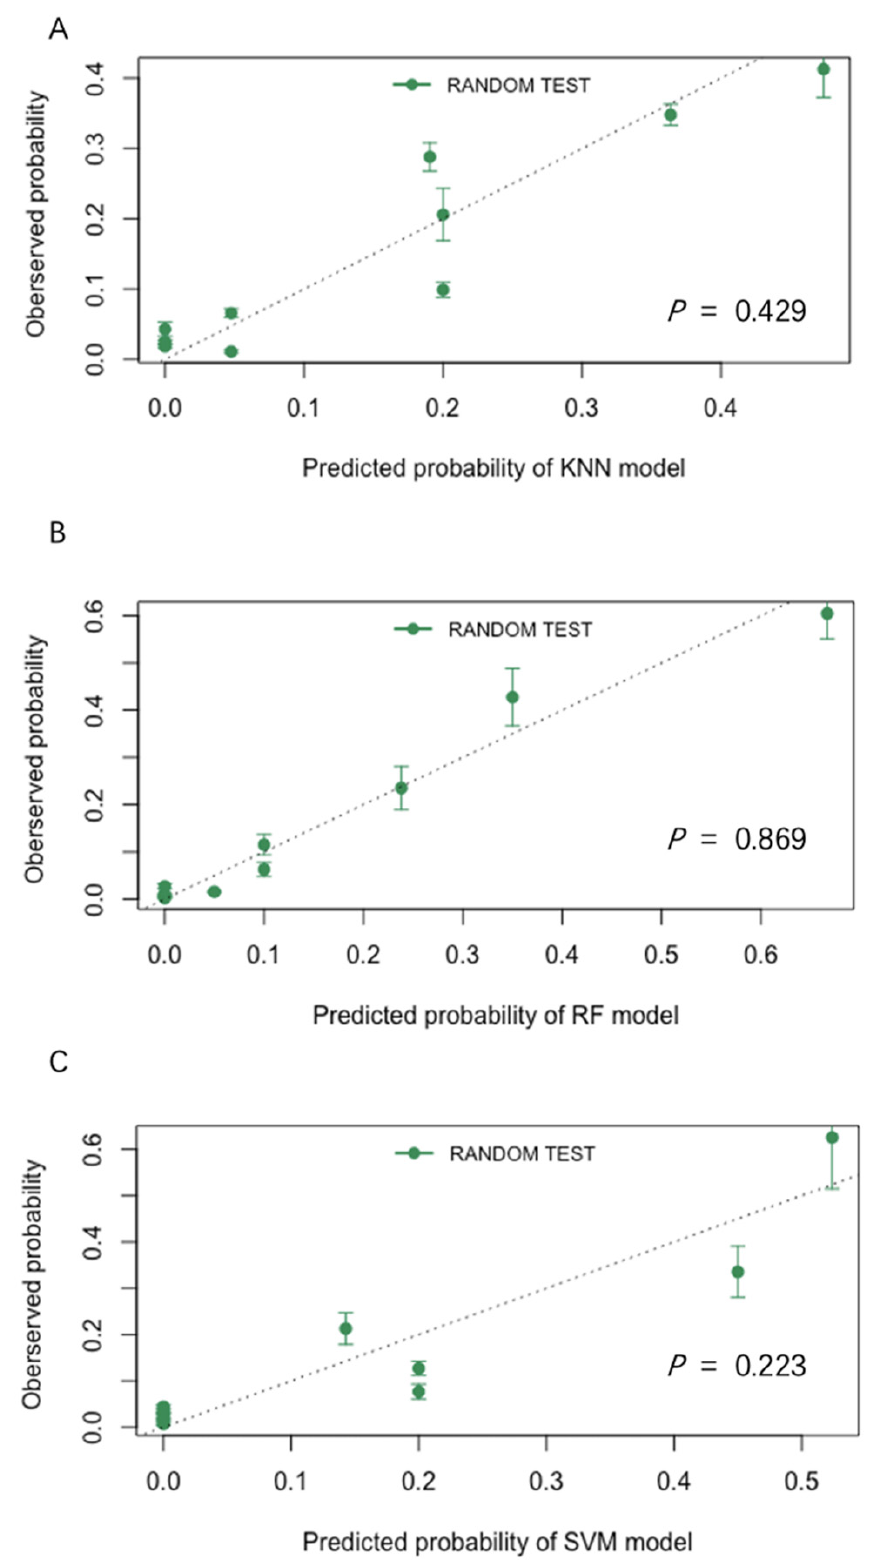
Figure 3. Calibration plots for the KNN(A), RF(B), and SVM(C) models. (KNN, k-Nearest Neighbor; RF, random forest; SVM, support vector machine). All models indicated appropriate calibration ( p > 0.05). ( A ) Calibration plot for the KNN model; ( B ) Calibration plot for the RF model; ( C ) Calibra- tion plot for the SVM model. Table 5. Comparison of the predictive performance for three models (fivefold cross-validation). The percentages of increase in mean square error (%IncMSE) and increased node pu- rity (IncNodePurity) were used to evaluate the importance of each variable in the model. The serum level of NT-pro BNP contributed the most (%IncMSE: 34.5) to the LAAV pre- diction, followed by the diagnosis of persistent AF (%IncMSE: 28.0), LA size (%IncMSE: 25.6%), BMI (%IncMSE: 14.7), weight (%IncMSE: 13.3%), etc. IncNodePurity relates to the